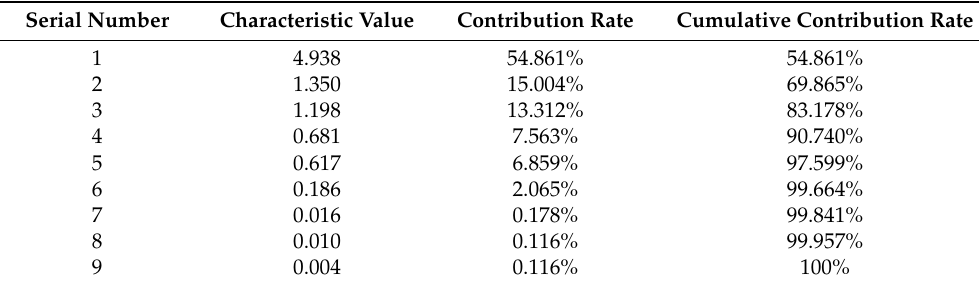
Table 4. Principal components and their contribution